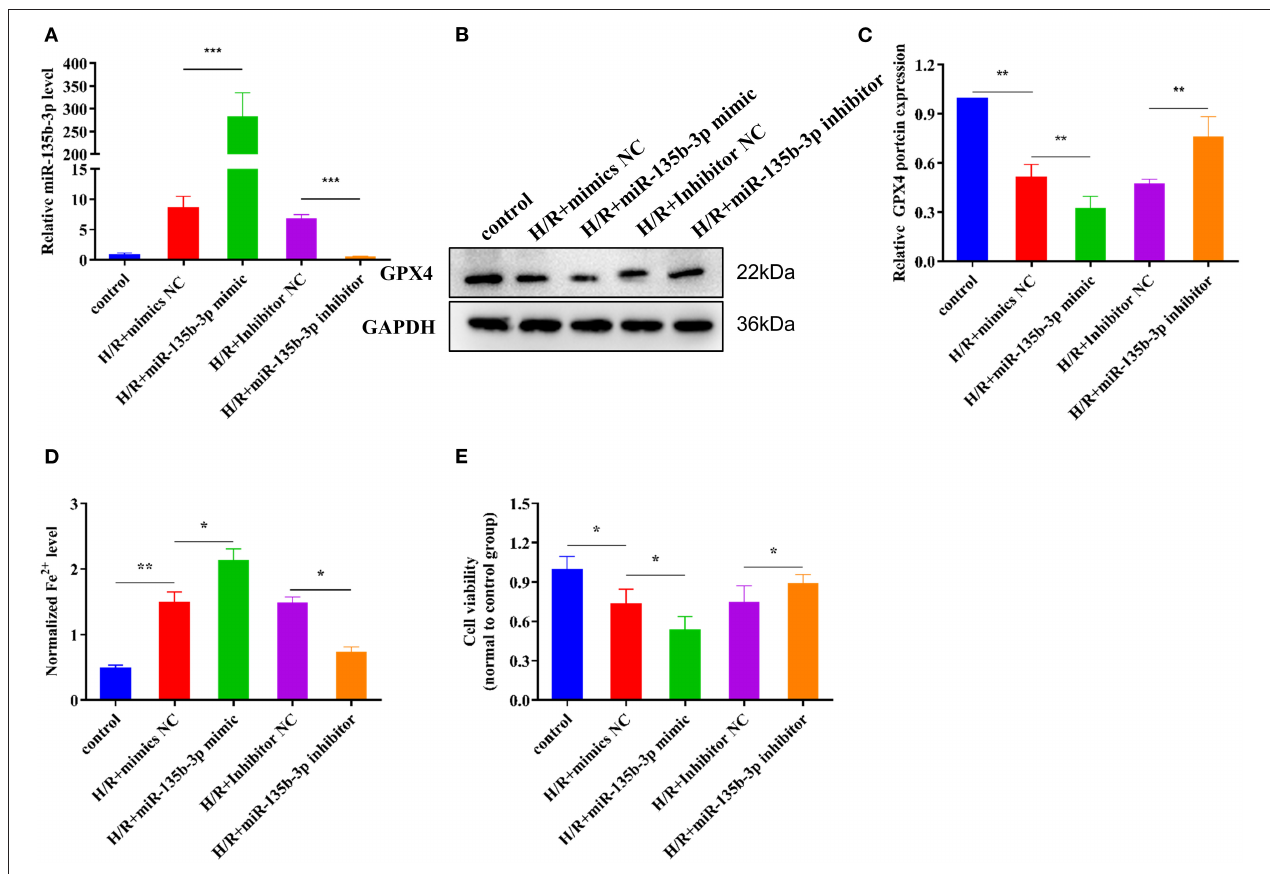
FIGURE 4 | miR-135b-3p promotes ferroptosis in H9C2 cells after H/R. This part of the study was based on untreated H9C2 cells and H/R-treated H9C2 cells, where miR-135b-3p expression was altered by mimics or an inhibitor in H/R H9C2 cells ( n = 3). (A) RT-qPCR-based detection of the expression of miR-135b-3p in control or H/R H9C2 cells after transfection with miR-135b-3p mimics, inhibitor, or corresponding control. (B) The expression of GPX4 in miR-135b-3p-overexpressing or miR-135b-3p-knockdown H/R H9C2 cells was detected by Western blotting; quantitative analysis is shown in (C) . (D) Ferrous iron level was detected in miR-135b-3p-overexpressing or miR-135b-3p-knockdown H/R H9C2 cells by using the iron assay kit. (E) MTT assay was used to analyze cell viability after altering the expression of miR-135b-3p. *** p < 0.001, ** p < 0.01, * p < 0.05. Results represent the average of three independent experiments. Error bars represent the mean ±